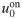
Rounds on target for input0 (= u0on, u0off, u0r) over 40 rounds on fine parameter grid with 66,086 grid points.With u0on∈{-1,…,1}, u0off∈{-2,…,2}, and u0r∈{-1,0,1}.